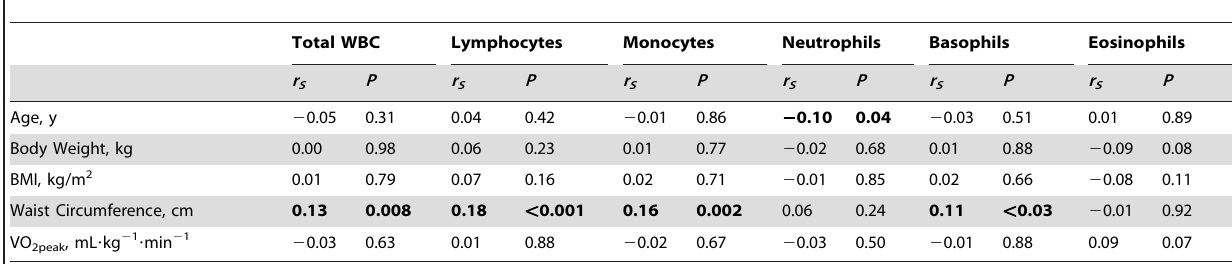
Table 3. Spearman correlation coefficients (r S ) between change in total WBC and WBC subfraction counts (cells/ m L) and changes in anthropometric data and cardiorespiratory fitness after 6 months of